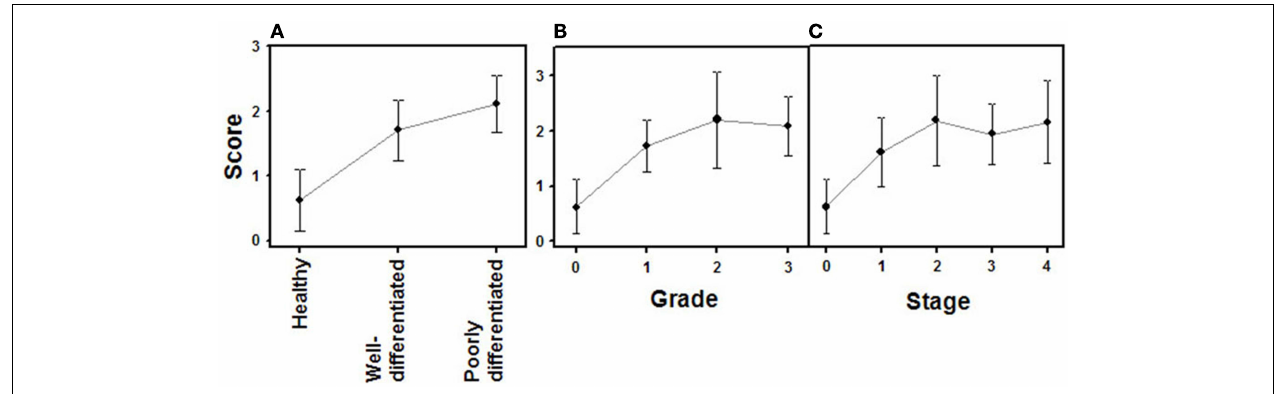
FIGURE 12 | Quantification of immunochemical staining of CS . (A) Relative to tumor differentiation. (B) Relative to tumor grade. (C) Relative to tumor stage. Semiquantitative scale from 0 to +++ was used.Vertical bars denote 0.95 confidence